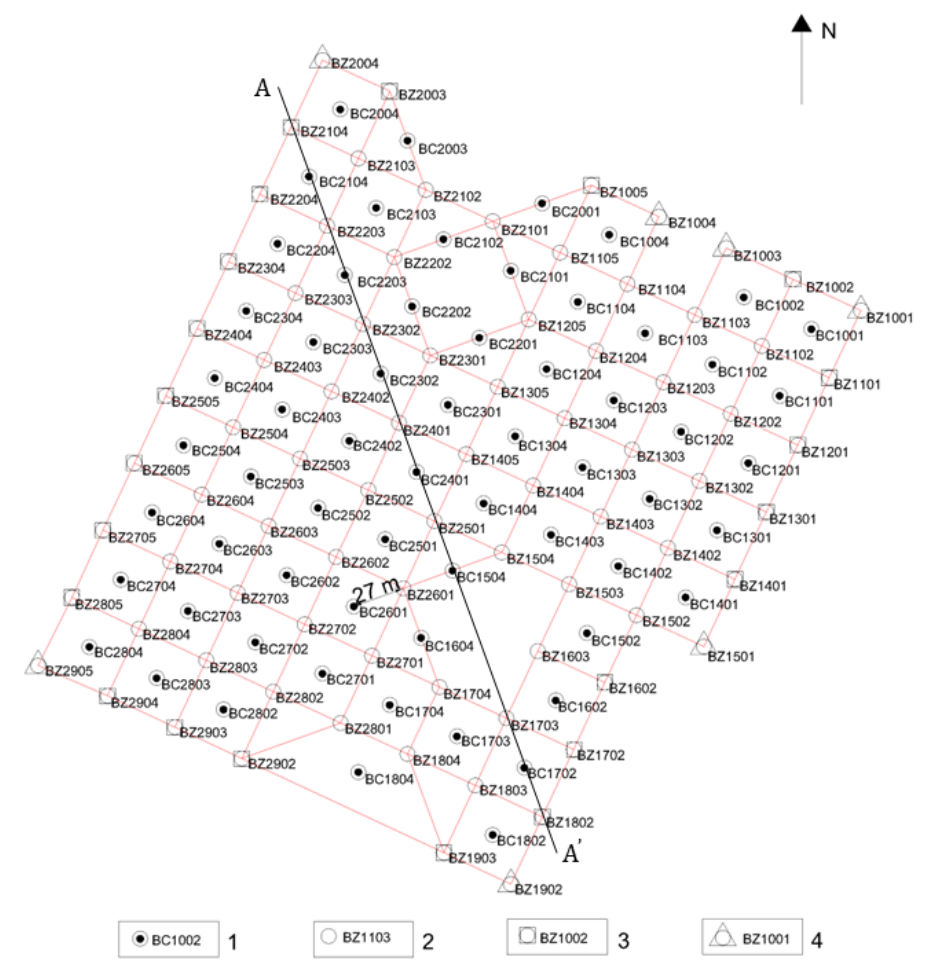
Figure 3. Distribution of the pumping and injection wells at the C1 and C2 mining areas of an in situ leaching uranium mine in Inner Mongolia. Note: 1 ‐ Pumping wells; 2 ‐ Internal injection wells; 3 ‐ Edge injection wells; 4 ‐ Top corner injection wells.